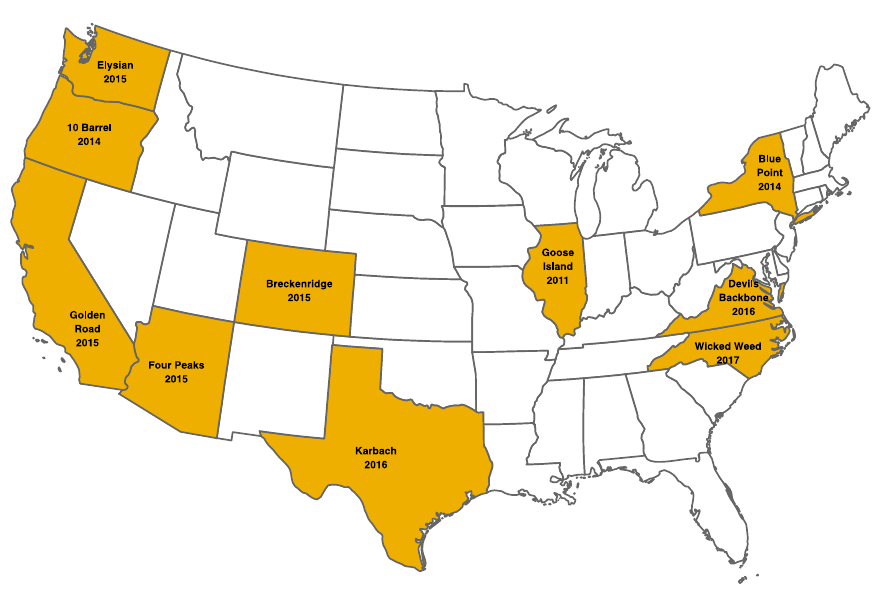
Figure 1. Geography of craft acquisitions made by Anheuser-Busch InBev in the United States, 2011 to 2017.